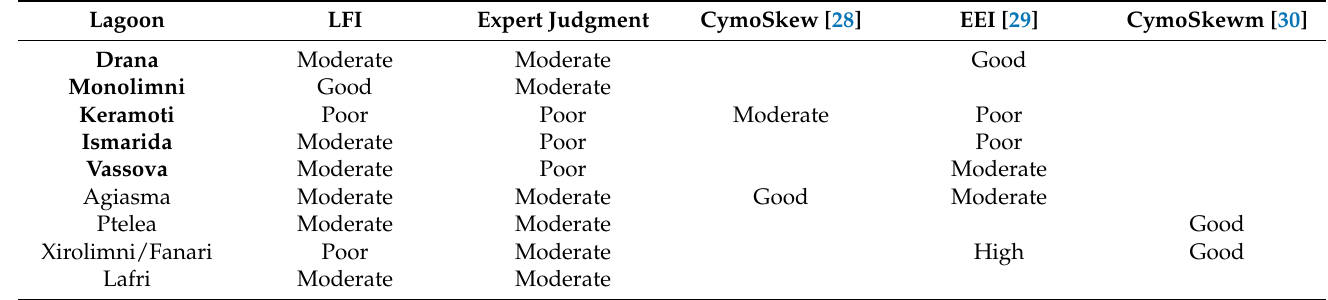
Table 5. Implementation of the LFI in lagoons situated in Northern Greece (Region of East Macedonia and Thrace). Shown in bold are the lagoons used for the development of the index. The results of the LFI are compared to expert judgment and three other indices using benthic macrophytic species (CymoSkew/Ecological Evaluation Index